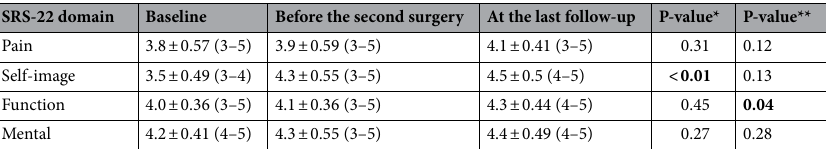
Table 3. Comparison of SRS-22 results at baseline, before the second surgery, and at the last follow-up after the second surgery. *: P-value from paired t-test comparing the values of baseline with ones before the second surgery. **: p-value from paired t-test comparing the values before the second surgery with those at the last follow-up after the second surgery. The second surgery: removal of L4 transient pedicle